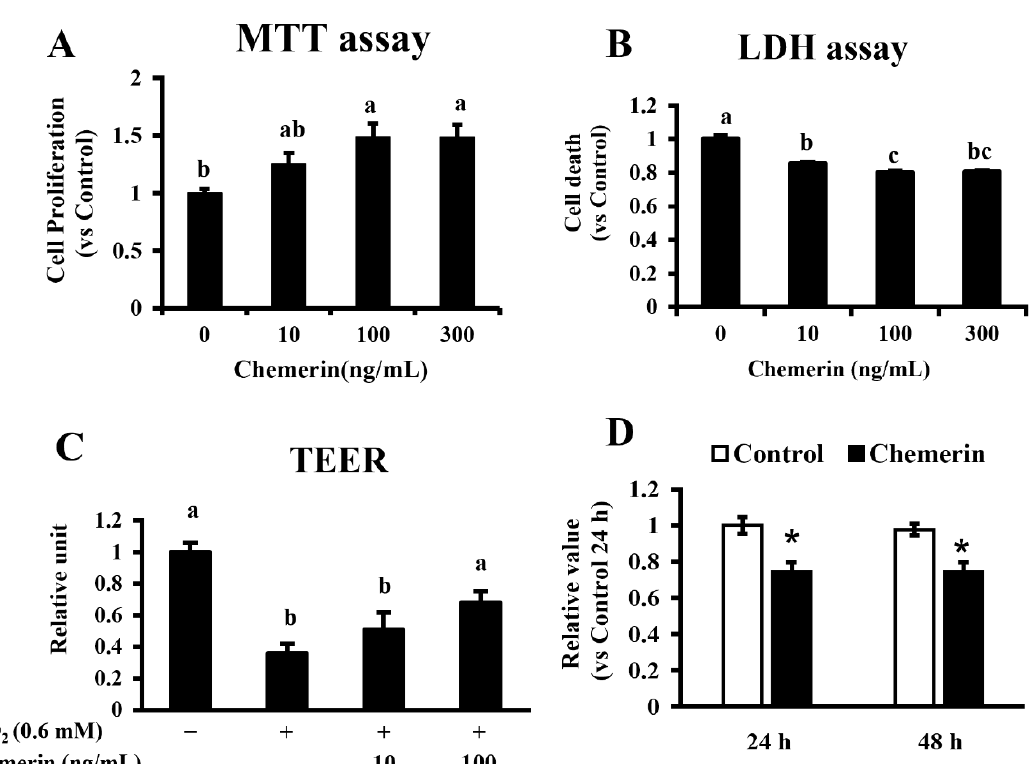
Figure 2. Protective effects of chemerin on mammary epithelial cells and PBMC. Immortalized bovine mammary epithelial cells (MAC-T cells) were cultivated in the presence of recombinant bovine chemerin for 24 h. Cellular proliferation and viability were measured by MTT ( A ) and LDH ( B ) assays. After reaching 100% confluency, MAC-T cells were cultured for 3 h in the presence/absence of H 2 O 2 with/without bovine chemerin at the indicated concentrations. The transepithelial electrical resistance (TEER) assay was also performed for epithelial barrier function ( C ). The PBMCs were incubated for 24 and 48 h with chemerin (100 ng/mL), and cell proliferation was analyzed by the Cell Counting Kit-8 (CCK-8) ( D ). Different alphabet letters represent statistical significance: p < 0.05 by Tukey-Kramer test ( A – C ). Asterisks indicate p < 0.01 vs. the control by student’s t -test.